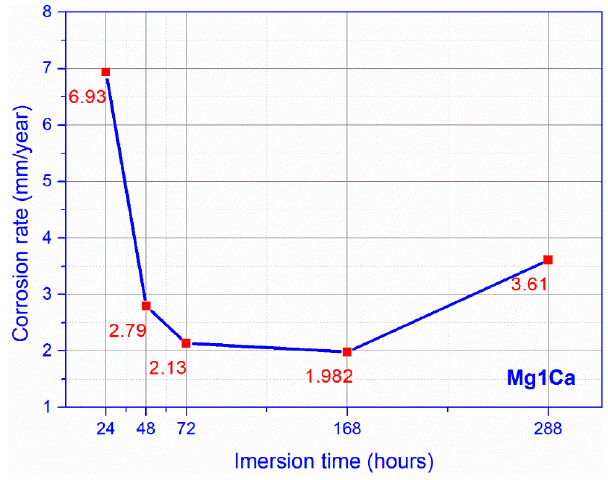
Figure 9. Corrosion rate, Dulbecco (mean values for three samples).